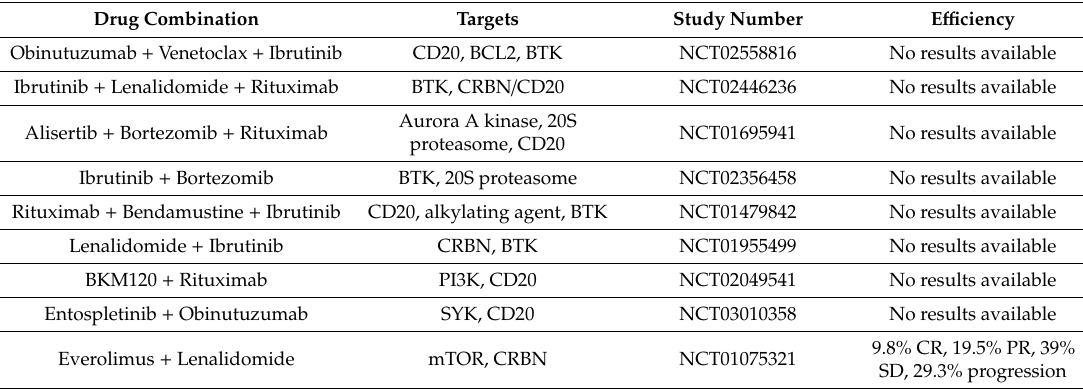
Table 2. Active clinical trials combining new biological agents in R / R